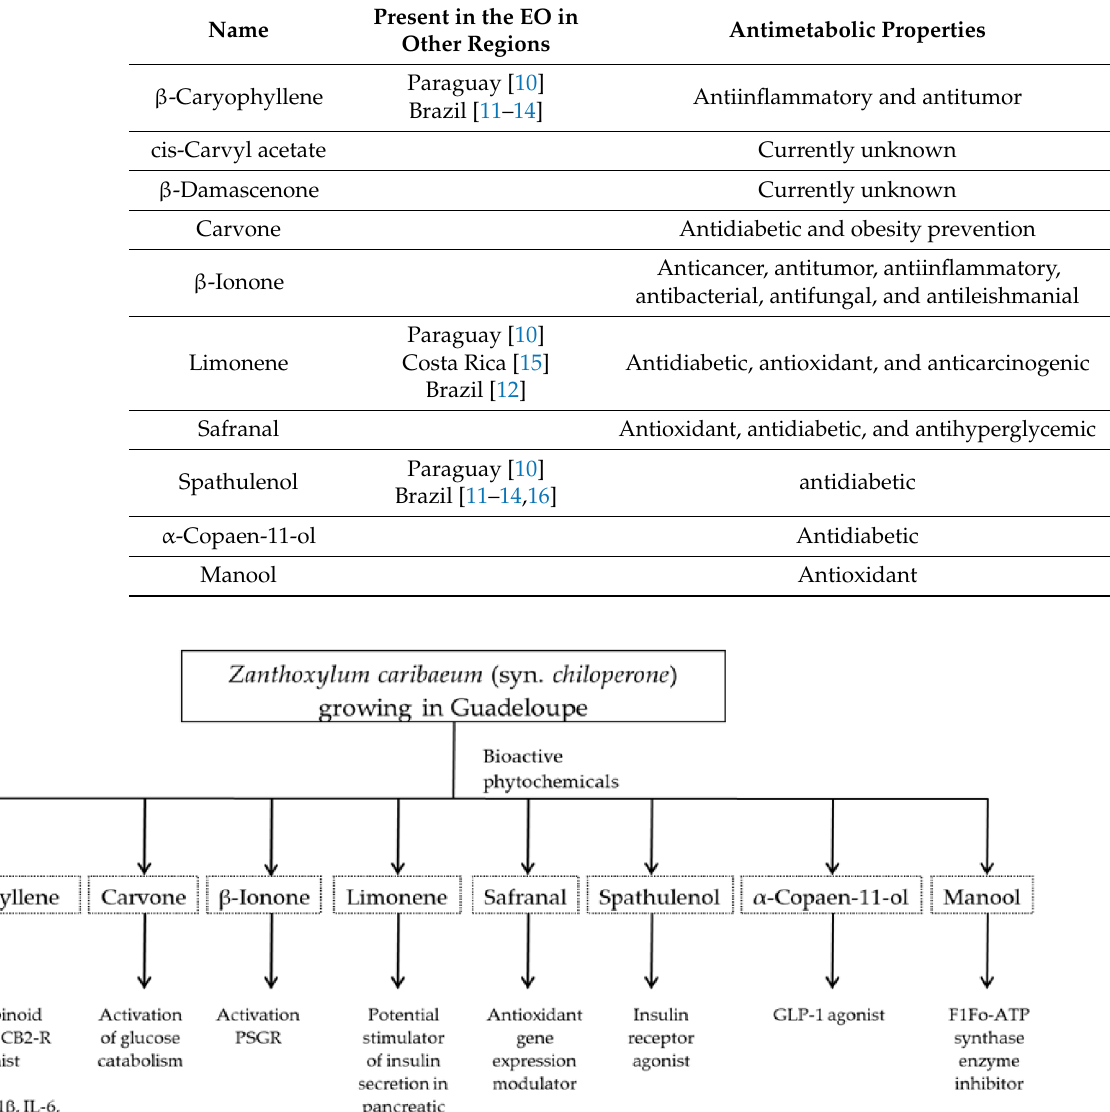
Table 2. Antimetabolic activities of molecules present in Zanthoxylum caribaeum essential oil from Guadeloupe.